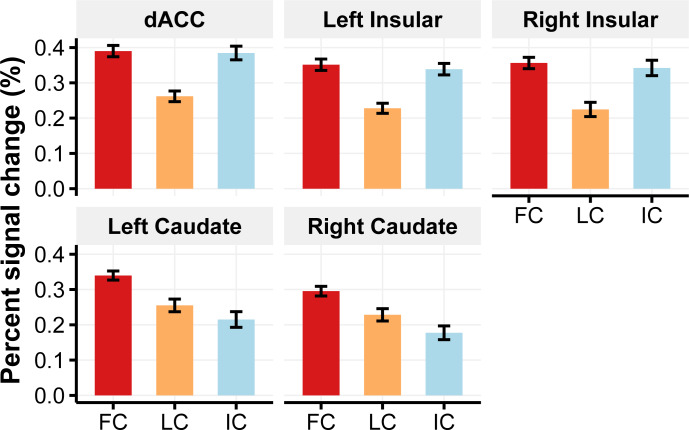
Brain activity as a function of memory performance.During A-C updating, the dACC, bilateral anterior insular cortex, and caudate showed greater activities (percent signal change) under the RetPrac condition than under the Restudy condition. Further analysis indicated that activations in these regions were differentially modulated by updating the performance of each item. Incorrectly recalled trials (IC) and the successfully recalled trials for the first time for a given item (first correct, FC) showed greater activation than items corrected recalled againfor a second or third time (later correct, LC) in the dACC and bilateral anterior insular cortex, indicating their role in conflict monitoring. By contrast, the caudate showed greater activity for FC trials than for all other trials, suggesting its role in positive prediction error. Error bars indicate within-subject standard errors. Please refer to Supplementary file 3c for statistical details.